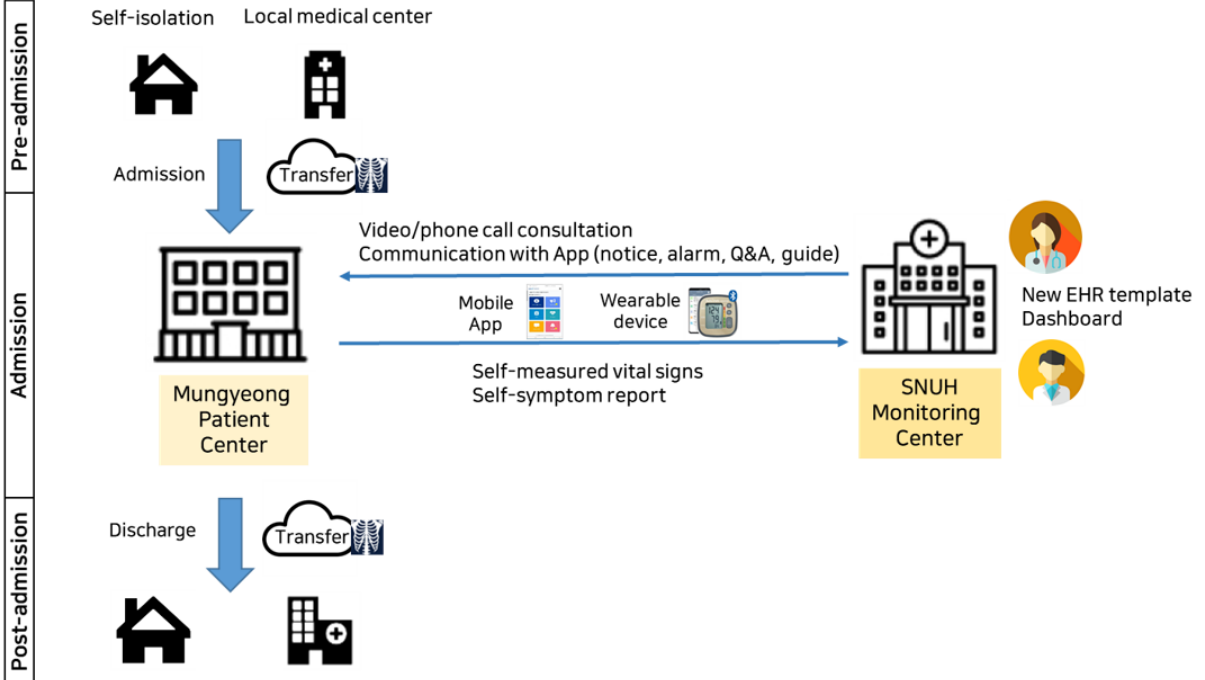
Figure 1. Overall ICT operation flow according to the patient's journey. EHR, electronic health record. ICT: information and communications technology. Q&A: question and answer. SNUH: Seoul National University